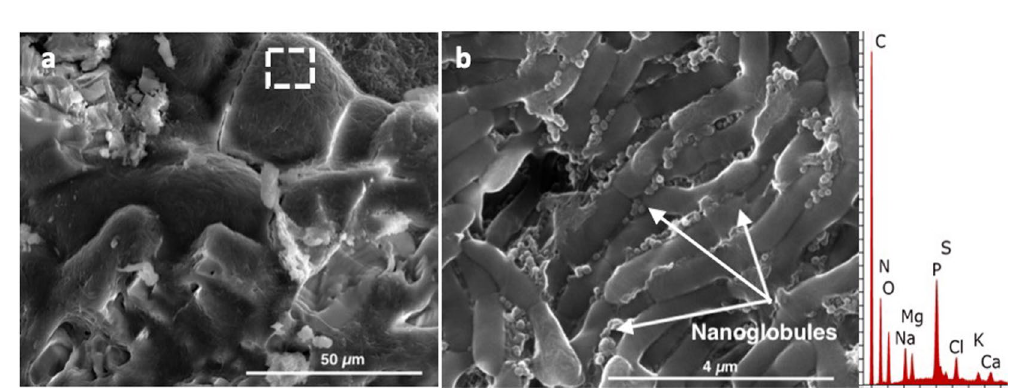
Figure 3. ( a ) Virgibacillus cells covering a carbonate mineral formed during the experiments. ( b ) Close-up image showing nanoglobules aggregates on the outer bacterial cells. EDS results indicate the bulk elemental composition of ( b ). Adapted from corresponding PhD Dissertation 71 .